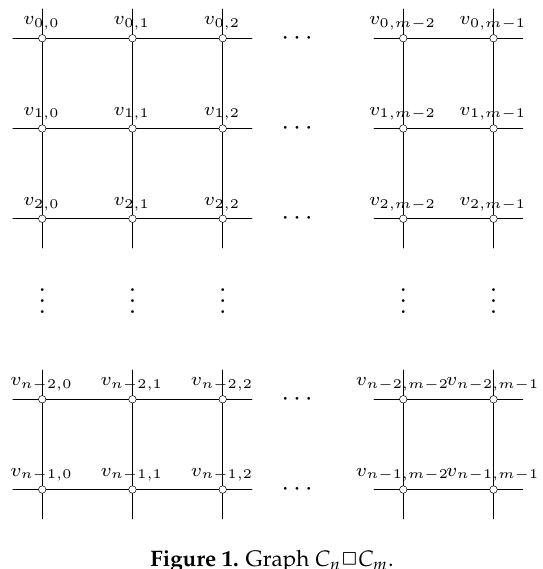
Figure 1. Graph C